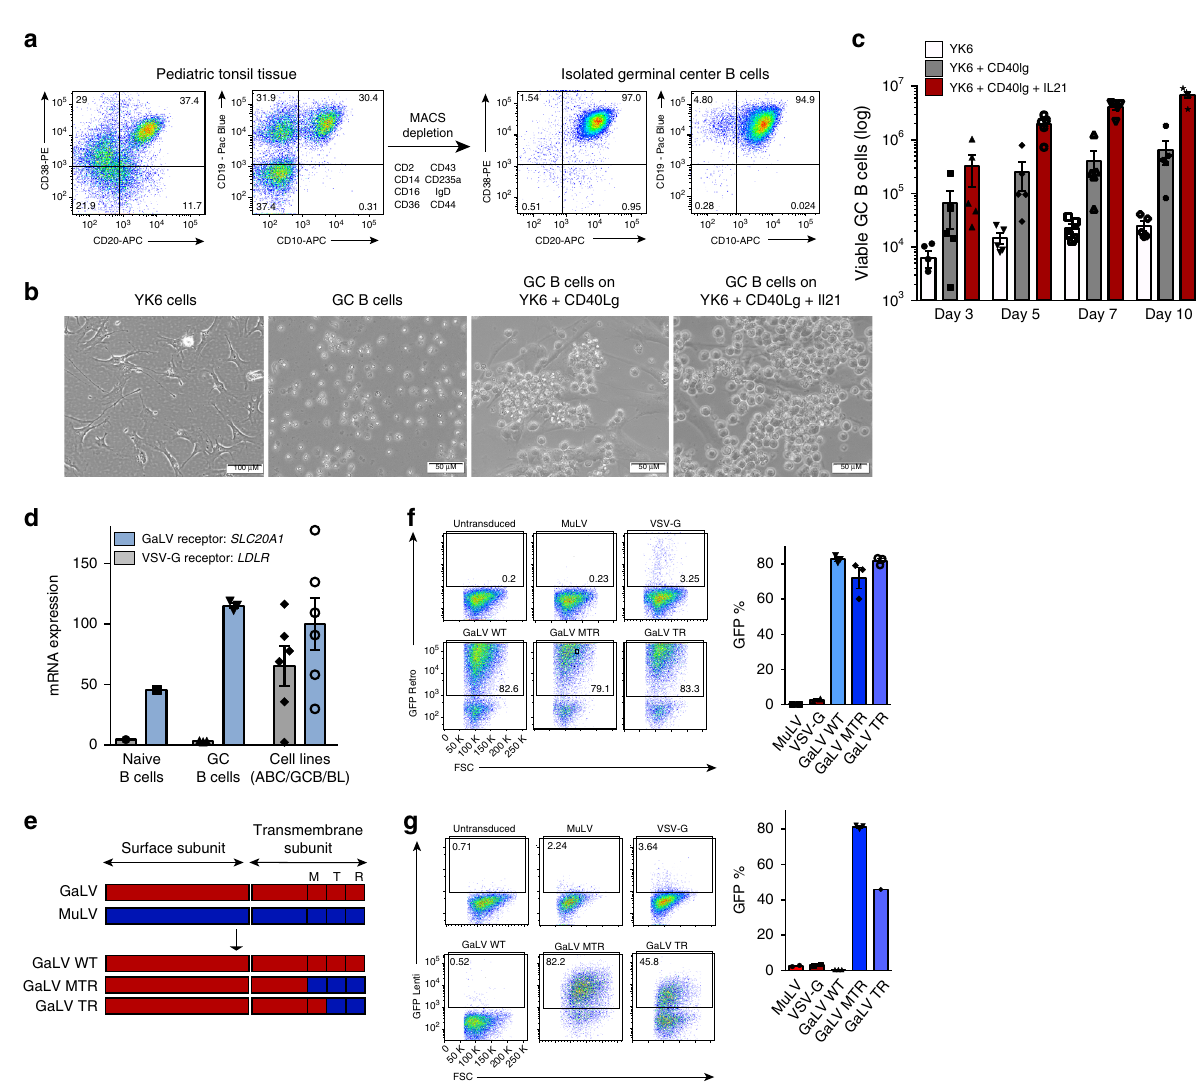
Fig. 1 Ex vivo growth and transduction of primary human GC B cells. a Representative fl ow cytometry analysis ( n > 3) for the expression of GC B cell markers CD38, CD20, CD19, and CD10 in puri fi ed GC B cells from pediatric tonsil tissue. The strategy for negative selection of GC B cells is shown. b Representative images are shown of YK6 cells, GC B cells alone, or GC B cells cultured on either YK6-CD40lg or YK6-CD40lg-IL21 feeder cells. Scale bar represents 50 or 100 μ m as indicated. Source data are provided as a Source Data fi le. c Primary human GC B cells were cultured with YK6 control, YK6- CD40lg, or YK6-CD40lg-IL21 feeder cells. Illustrated is bar graph showing the number of viable cells ( ± s.e.m., n = 5) over four timepoints. Viable cells were determined by fl ow cytometry and counting beads. Source data are provided as a Source Data fi le. d Bar graph showing the relative transcript expression of SLC20A1 (GaLV receptor) and LDLR (VSV-G receptor) in naïve ( n = 1), GC B cells ( n = 3), and ABC/GCB DLBCL and Burkitt cell lines ( n = 6) as analyzed by RNA-seq. mRNA expression values were calculated as counts per million reads (CPM). Error bars indicate ± s.e.m. Source data are provided as a Source Data fi le. e Schematic of the retroviral and lentiviral MuLV-GaLV fusion envelopes, GaLV_WT, GaLV_MTR, and GaLV_TR. M = transmembrane region, T = cytoplasmic tail, R = R peptide, SU = surface subunit, TM = transmembrane subunit 19 . f , g Primary human GC B cells were transduced with a retroviral control ( f ) or lentiviral control ( g ) construct using GaLV-MuLV fusion envelope constructs as well as VSV-G and MuLV. Three days after transduction, transduction ef fi ciencies in primary human GC B cells were determined by expression of GFP. Error bars indicate ± s.e.m., n = 3. FSC forward scatter. Source data are provided as a Source Data fi